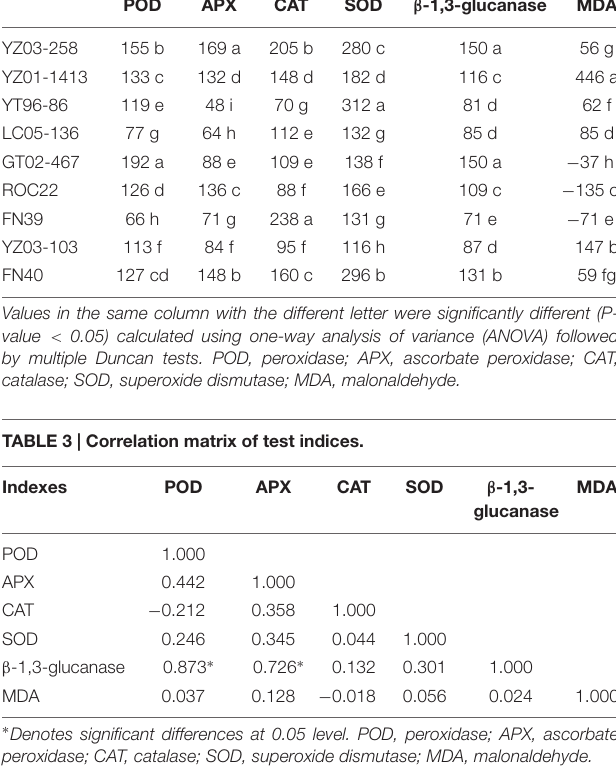
TABLE 2 | Disease-resistance coefficients of physiological and biochemical indices in different sugarcane varieties. Variety